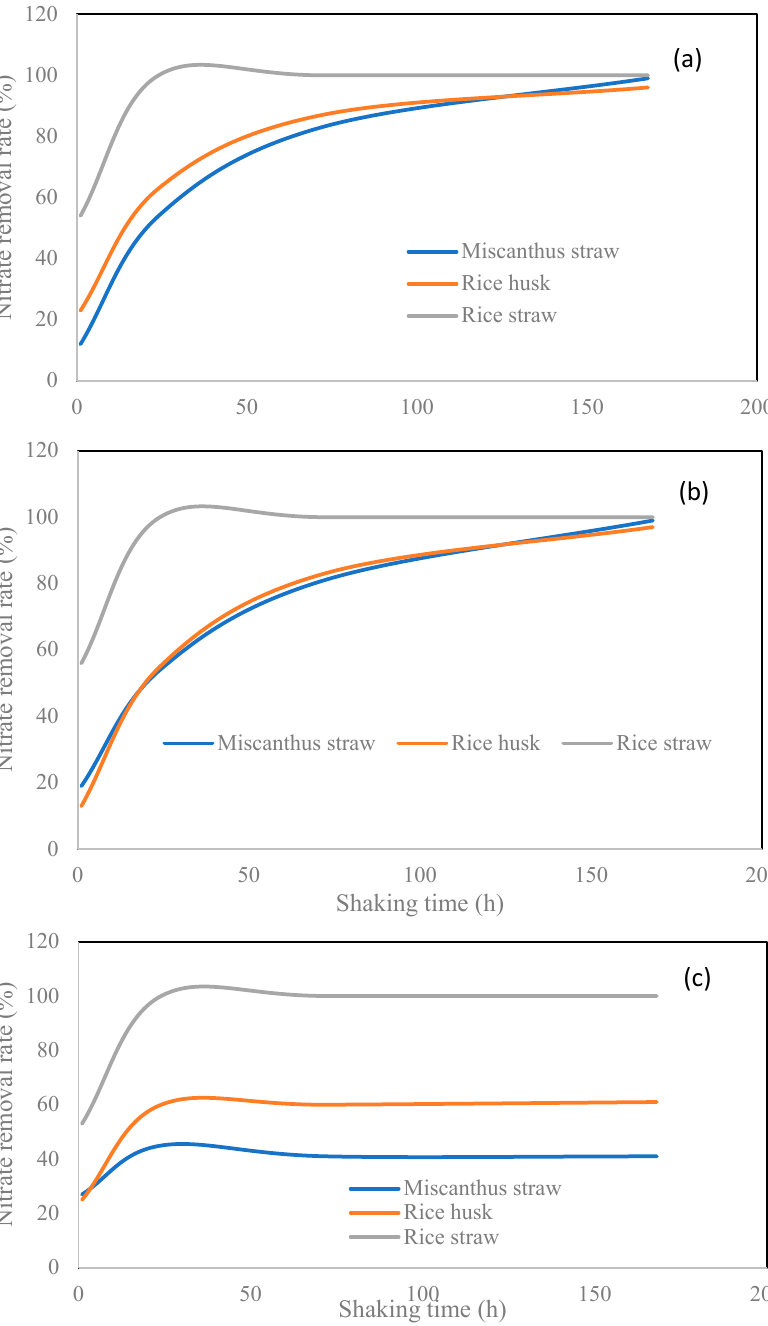
Figure 4. A comparison of nitrate removal by three different biochar materials in the presence of ( a ) citric acid, ( b ) oxalic acid, and ( c ) malic acid (data on the miscanthus and rice husk biochars were from Heaney et al. [11]).